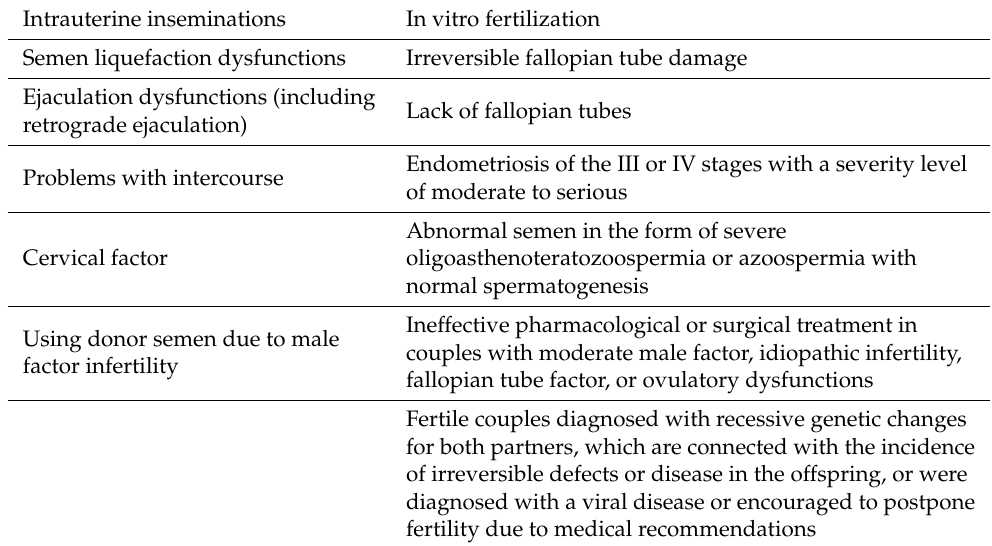
Table 1. Principal recommendations for IUI [23] and in vitro fertilization